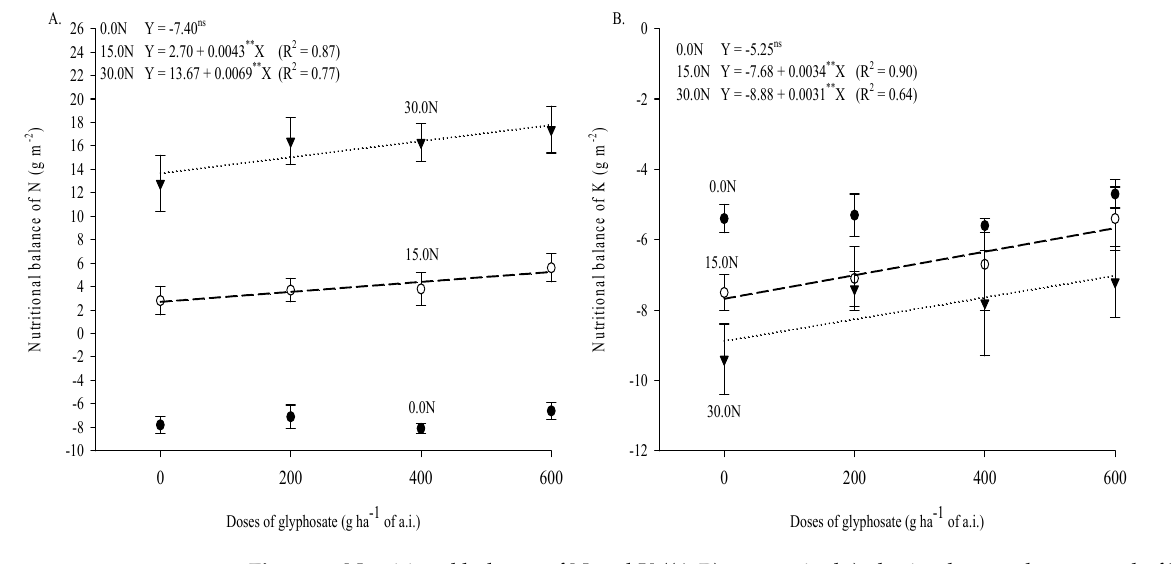
Figure 5. Nutritional balance of N and K (( A , B ), respectively) obtained upon the removal of leaves (“clippings”) and application of N to emerald grass as a function of doses of glyphosate. The letters correspond to a significant difference at the 5% probability level ( p ≤ 0.05). ns and **: not significant and significant at p < 0.01, respectively. Error bars indicate the standard deviation of the mean ( n = 4).